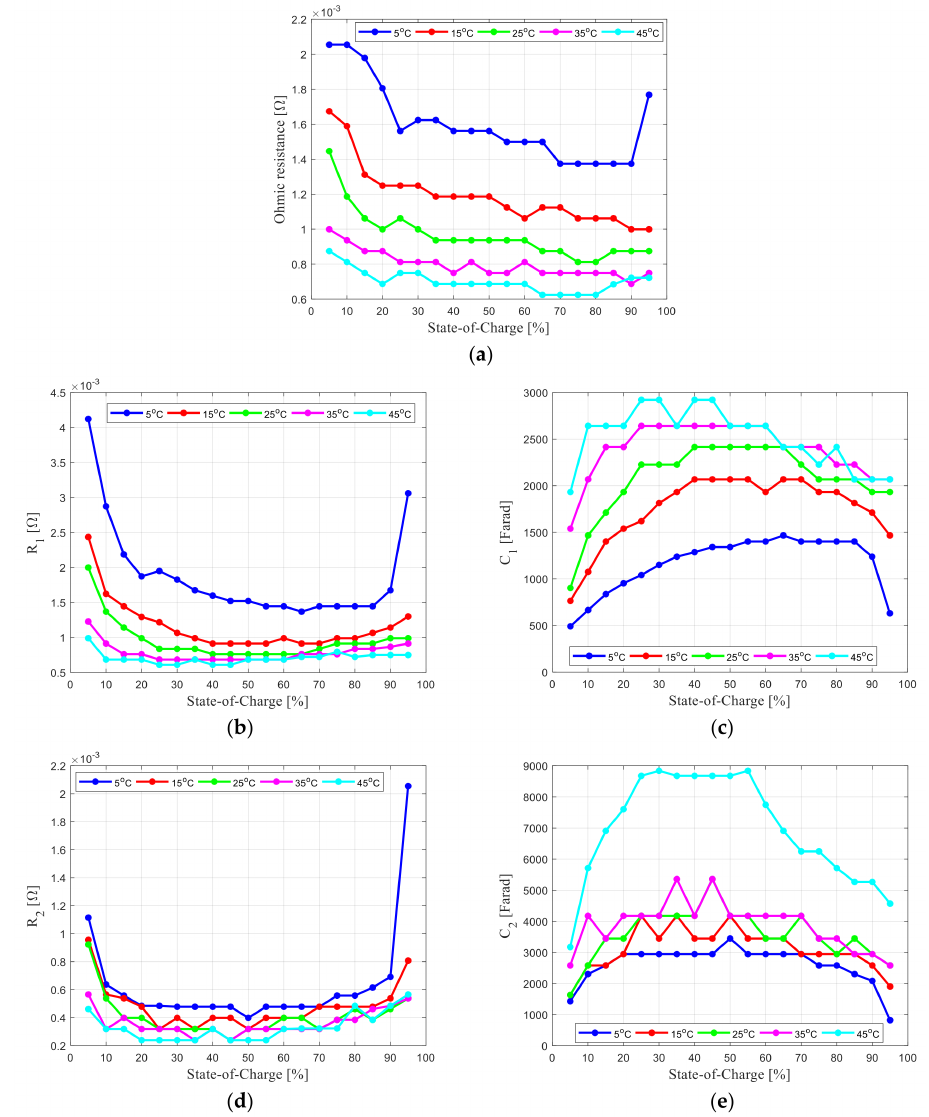
Figure 8. Variation of EEC parameters ( a ) R 0 ; ( b ) R 1 ; ( c ) C 1 ; ( d ) R 2 ; ( e ) C 2 with SOC and